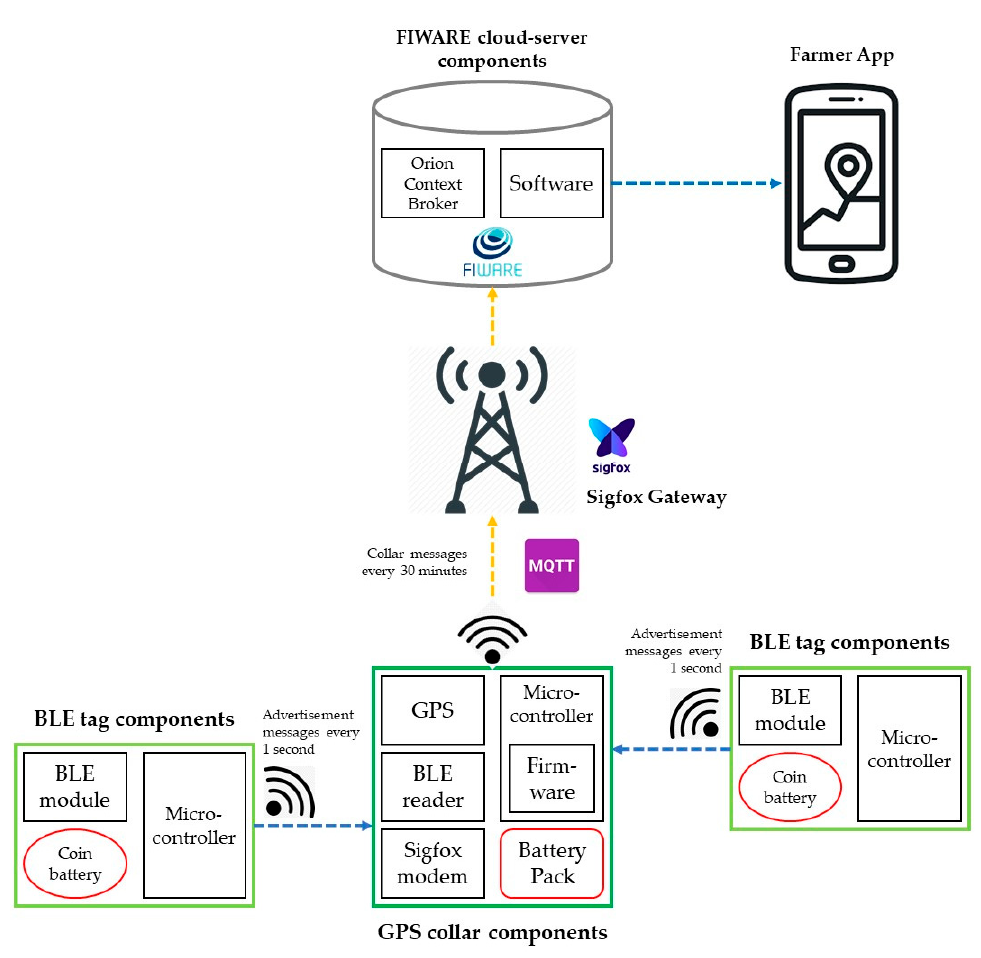
Figure 1. Architecture diagram of the proposed solution.